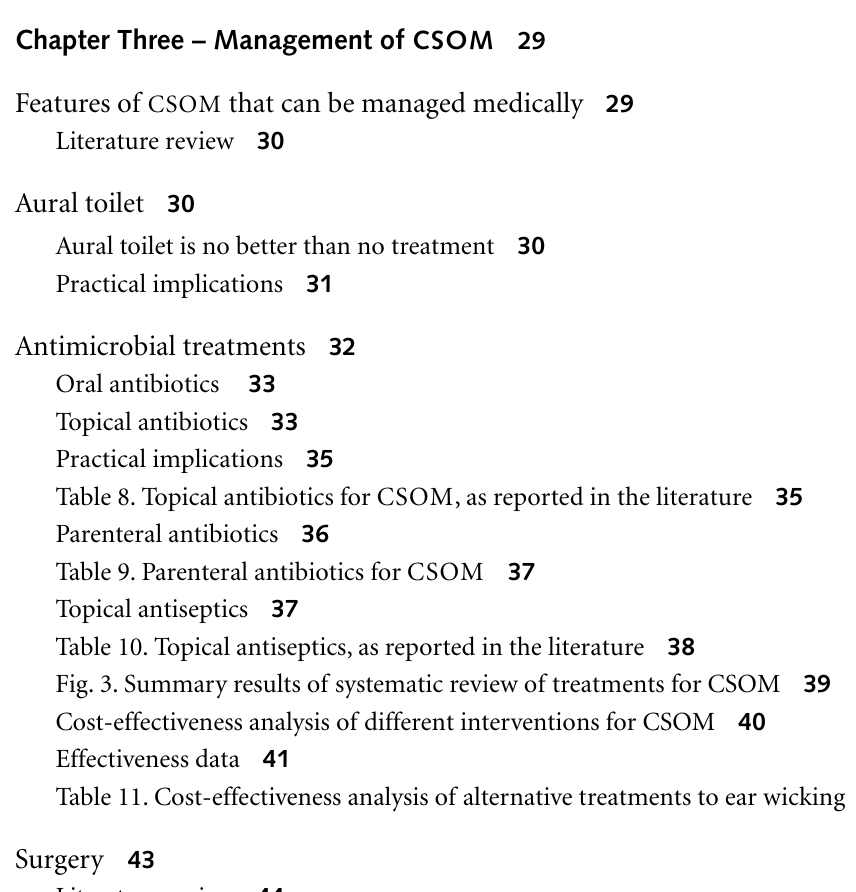
Table 12. Results of mastoidectomy for CSOM